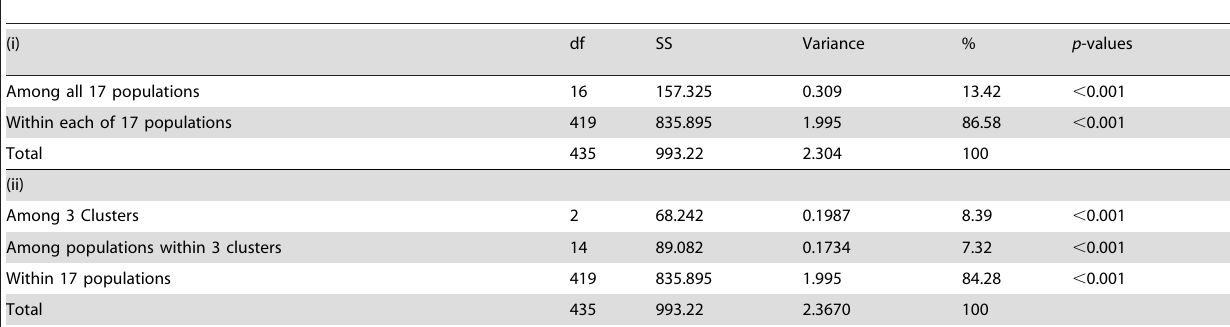
Table 3. Analysis of Molecular Variance (AMOVA) for Leptographium longiclavatum populations based on (i) sampling locations and (ii) three genetic clusters pooled according to the PCoA and STRUCTURE (Degrees of freedom (df), sum of squares (SS), variance estimates, percentages of total variation (%) contributed by populations, clusters and individual isolates within populations are